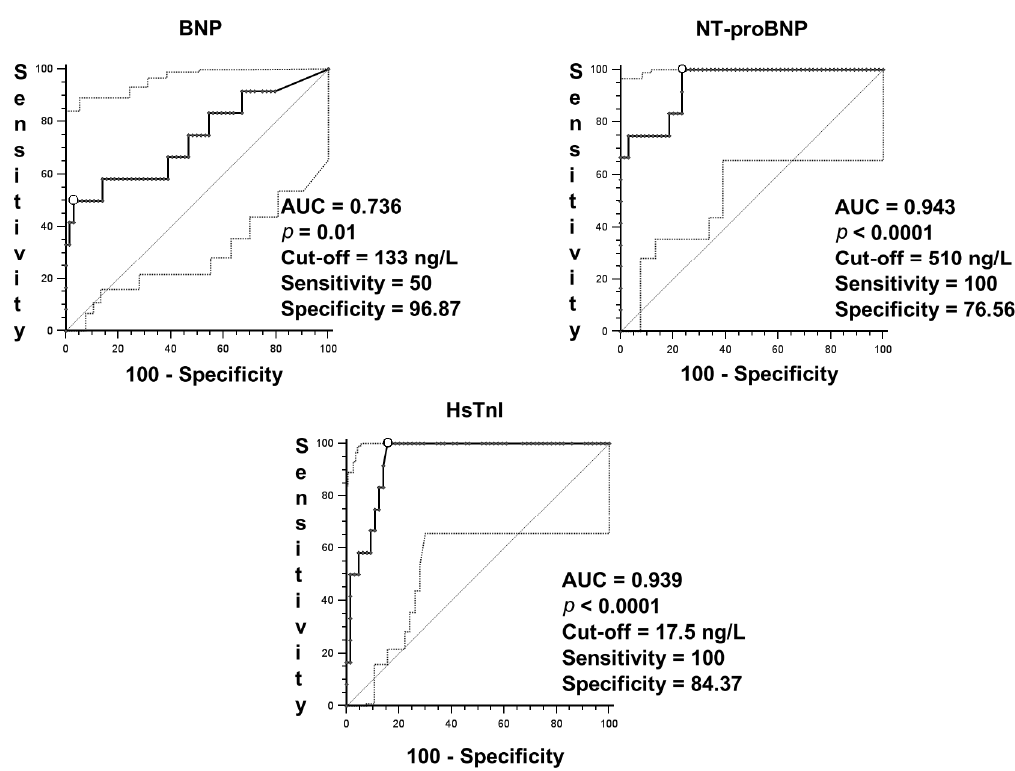
Figure 1. ROC curves for NT-proBNP, BNP and HsTnI concentrations at admission. The receiver operating characteristic (ROC) curve is indicated with a line in bold and full circles represent the criterion points. The open circle indicates the cut-off point. The light line indicates the bisector and dotted lines indicate 95% confidence intervals.